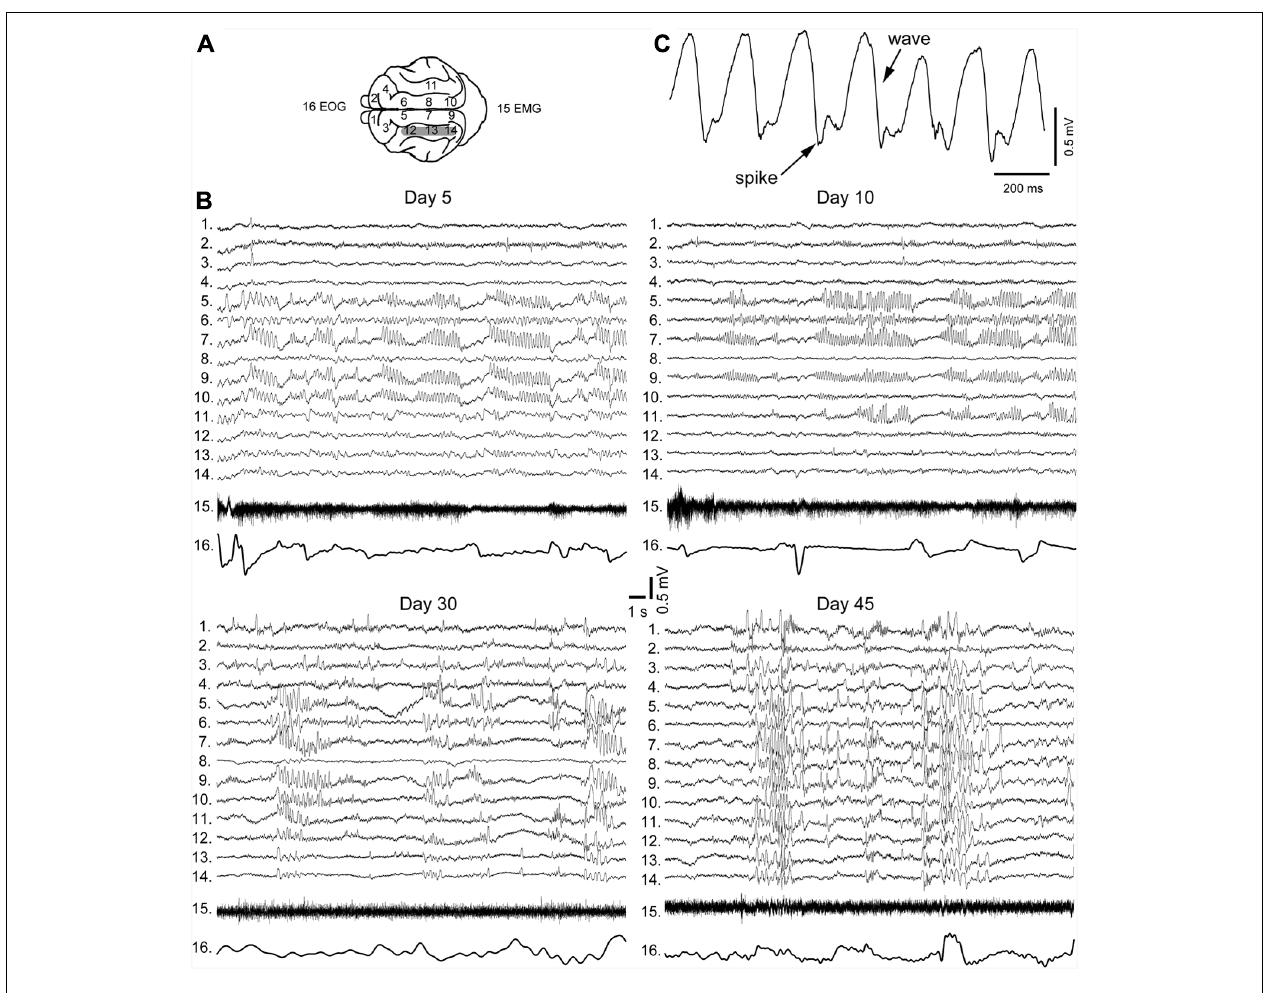
FIGURE 3 | Electrographic signatures of partial deafferentation-induced epileptogenesis in a cat. (A) Location of recording electrodes in cats brain. (B) Paroxysmal activities recorded at 5, 10, 30, and 45 days post-surgery.